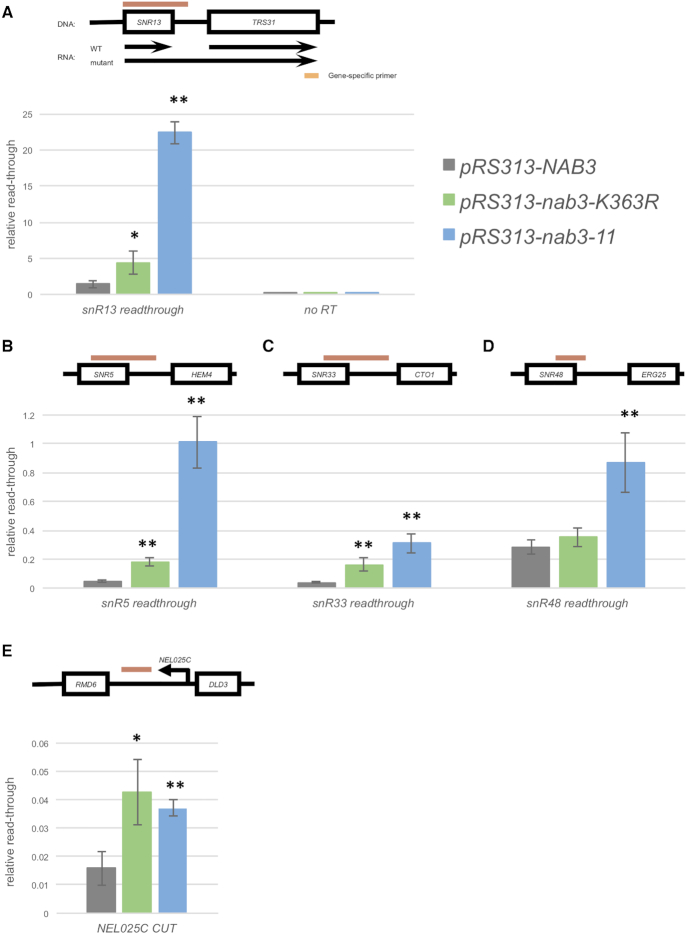
The Nab3-K363R mutant exhibits transcription termination defects at several noncoding RNAs. (A) Total RNA from NAB3, nab3-K363R, and nab3-11 cells was processed into cDNA using a TRS31 gene specific primer (illustrated as an orange rectangle). The presence of SNR13 read-through transcription was analyzed by qPCR using a forward primer that anneals within the snoRNA and a reverse primer that anneals at a downstream intergenic region. The qPCR product is represented by the red rectangle. (B–E) Total RNA from NAB3, nab3-K363R and nab3-11 cells was processed into cDNA using random nonamers. Read-through transcription was measured at the following snoRNA genes: (B) SNR5, (C) SNR33, (D) SNR48. RT-qPCR was also used to measure levels of the (E) NEL025c CUT. qPCR signal from the read-through and NEL025c primers was normalized to ACT1 mRNA levels, which appear comparable in all three strains. Error bars represent standard deviation of three biological replicates. Significance between each mutant and the WT control (pRS313-NAB3) is calculated by a two-tailed Student's t-test and denoted by *P < 0.05, **P < 0.01. No reverse transcription control (No RT, n = 1).